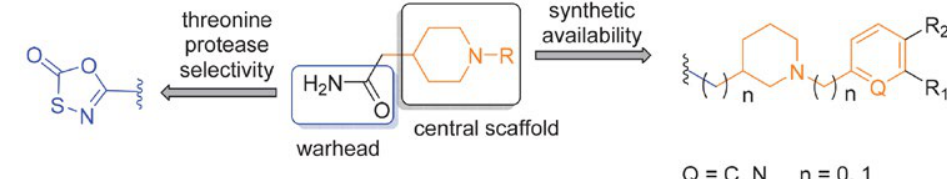
Figure 3. Design of piperidin-3-yl-oxathiazol-2-ones as potential covalent inhibitors of threonine